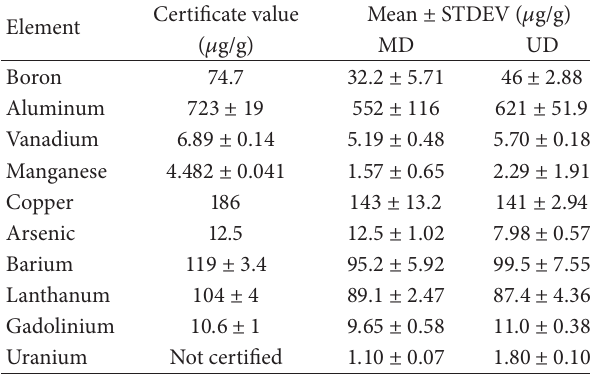
Table 2: Metal concentrations (ppm range) of NIST 2483-CNT SRM obtained with both microwave digestion (MD) and ultrasonic digestion (UD) methods. The results are presented as mean ( 𝜇 g/g) and standard deviation of five independent